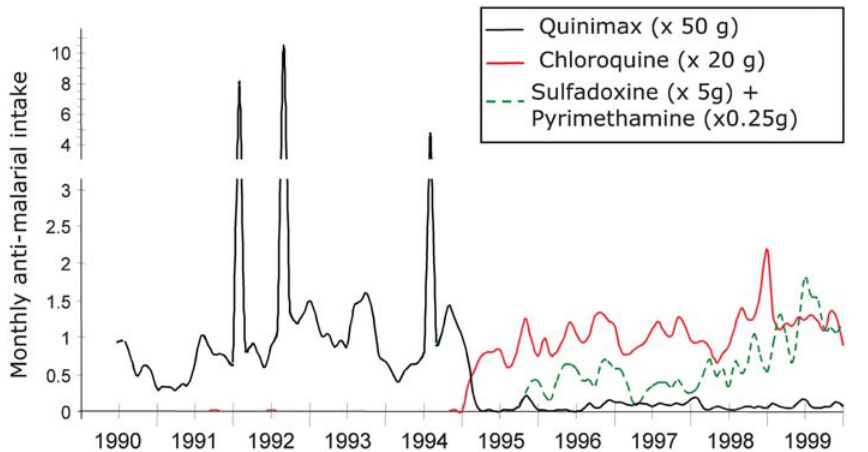
Figure 1. Amount of antimalarials used in Dielmo from 1990 to 1999. The mean number of person-years surveyed was 124 in 1990 (from June to December) and 295, 235, 238, 262.8, 260.1, 257.1, 292.5, 288.7, 299.3 and 297.8 from 1991 to 1999, respectively. The cumulated survey days were 51745, 81120, 82583, 90761, 89551, 88908, 100706, 95917, 100942 and 99083 from 1990 to 1999, respectively. The monthly quinine, CQ and SP intake was calculated from the recorded drug prescriptions in the data base. For , 5% of cases, the actual prescribed dose was not available and was extrapolated from the standard treatment course at that time in the village. The peaks in 1992 and 1994 correspond to eradication therapies administered to 100, 118, and 59 persons, respectively [21,22]. There were 155, 262, 567, 310, 428, 435, 710, 649, 681 and 823 treatment courses administered from 1990 to 1999, respectively.